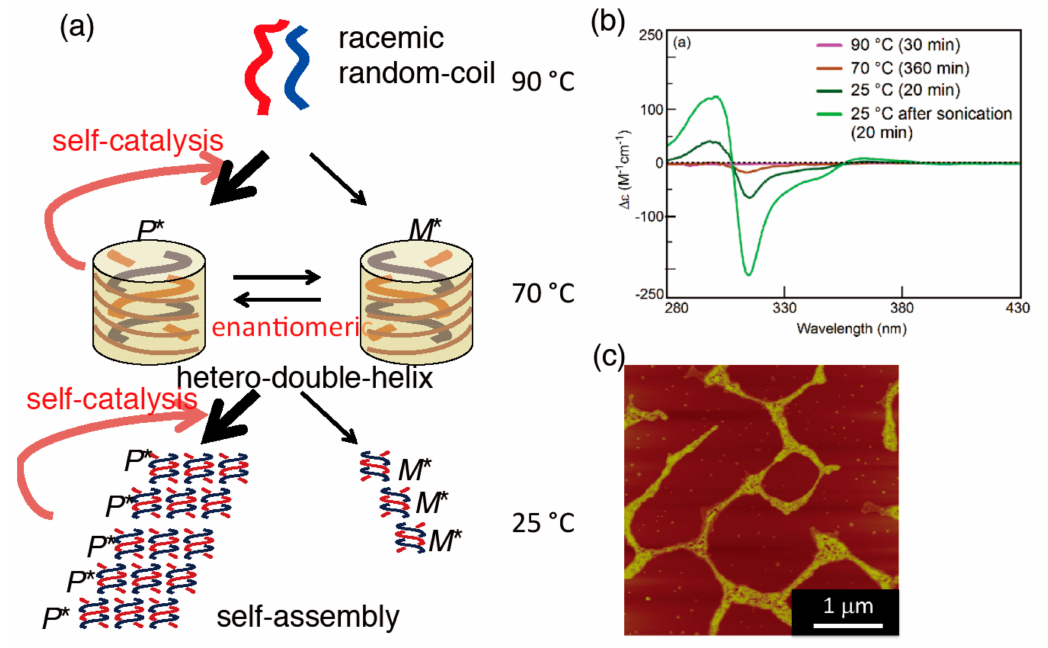
Figure 25. Schematic presentation of chiral symmetry breaking of racemic aminomethylehehelicene ( ± )-pentamer ( a ) as shown by development of CD spectra ( b ) and AFM images of resultant fibers ( c ). Reproduced from reference 79 by permission from John Wiley & Sons.